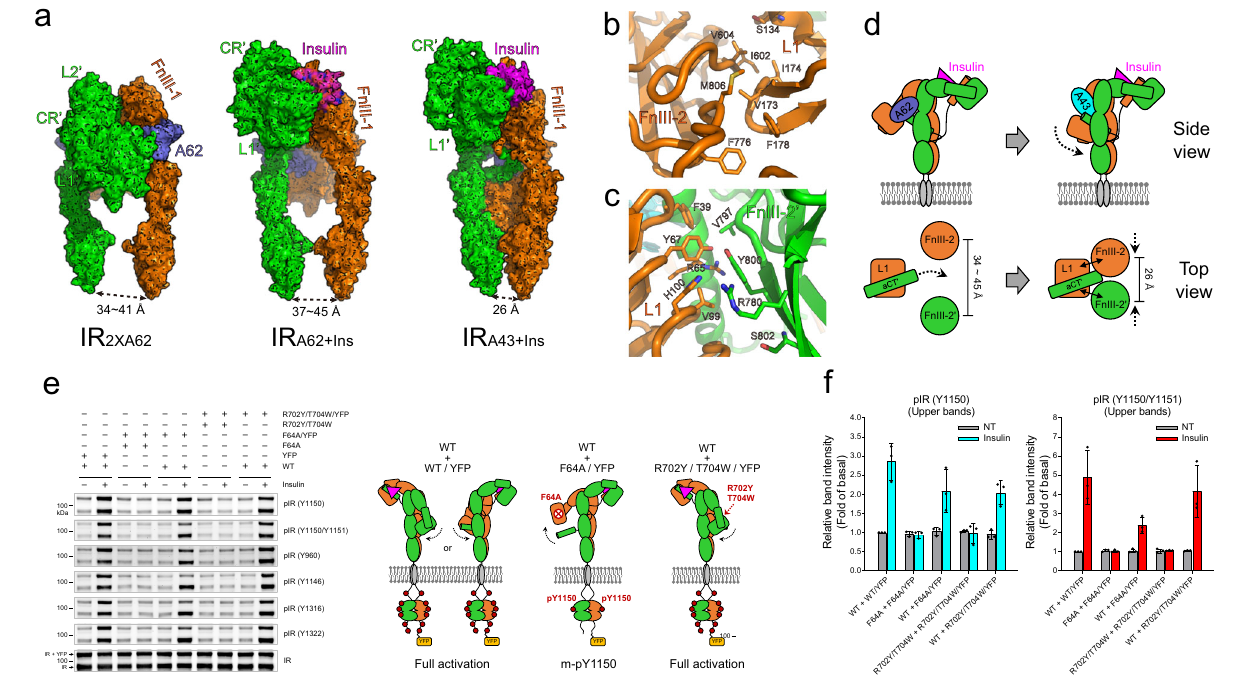
Fig. 4 | The position of the non-insulin-bound L1 domain determines the autophosphorylation state of IR. a Comparison of the IR 2xA62 (left), IR A62+Ins (middle) and IR A43+Ins (right) structures. Side views of the structures are shown in surface representation to highlight the arrangement of FnIII-3 stalks. Each proto- mer is colored green or orange. A62 is colored violet and insulin is colored magenta. The distance between the membrane-proximal ends (Asp907) of the stalks is highlighted. b , c Interaction of the L1 domain (orange) with b FnIII-2 (orange)and c FnIII-2 ′ (green)intheIR Ins+A43 structure. d Cartoonrepresentationof